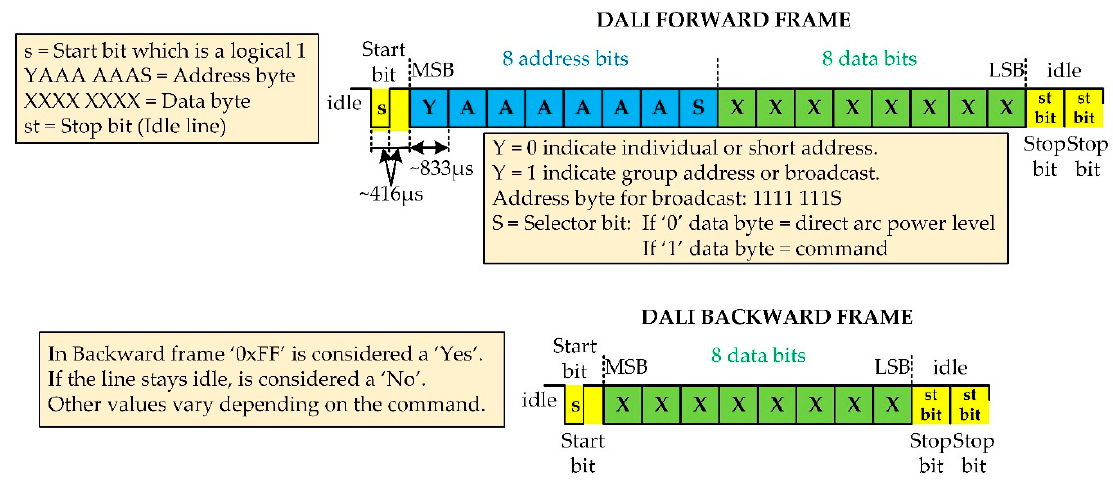
Figure 1. Digital Addressable Lighting Interface (DALI) protocol two-way communication message structure (forward & backward frames).